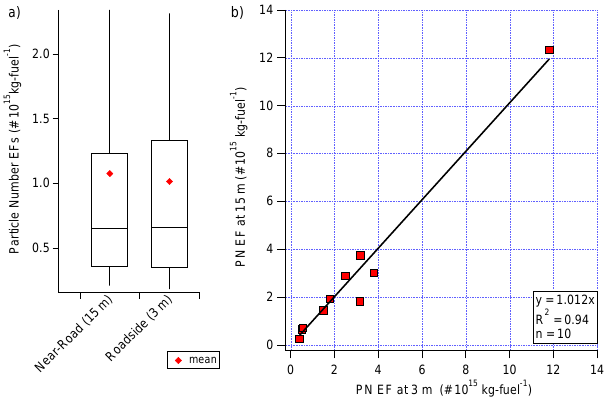
Figure 4. Particle number emission factors comparison between coincident roadside (3m) measurements and the near-road inlet (15m), including all captured plumes ( n = 282) from the test pe- riod (a) and individual plumes ( n = 10) from the same vehicles (b) . Horizontal lines represent the median values, boxes represent the 75th percentile and whiskers represent the 90th